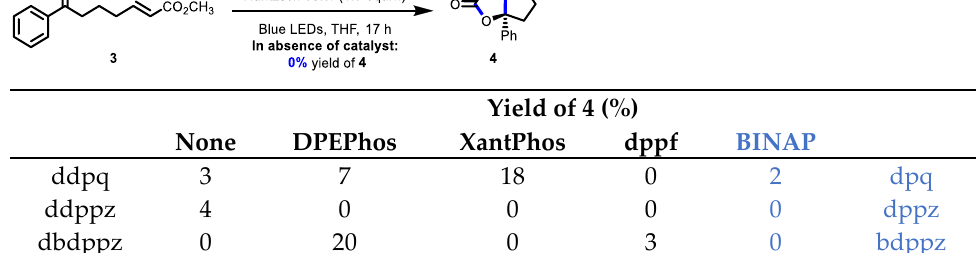
bdppz Figure 6. Comparison of the BINAP -containing copper complexes bearing π -extended ligands in an energy transfer process. Figure 7. Ligand effects in heteroleptic copper complexes in an energy transfer process.